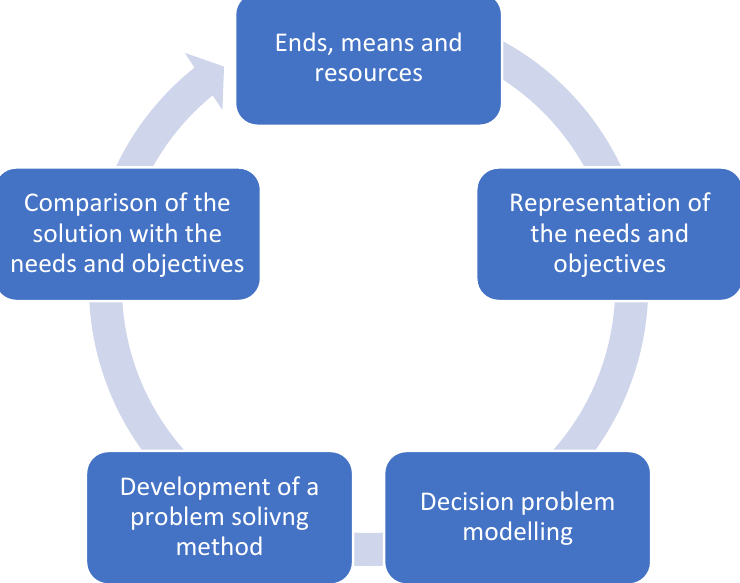
Figure 1. Scheme of the general methodology (own elaboration).